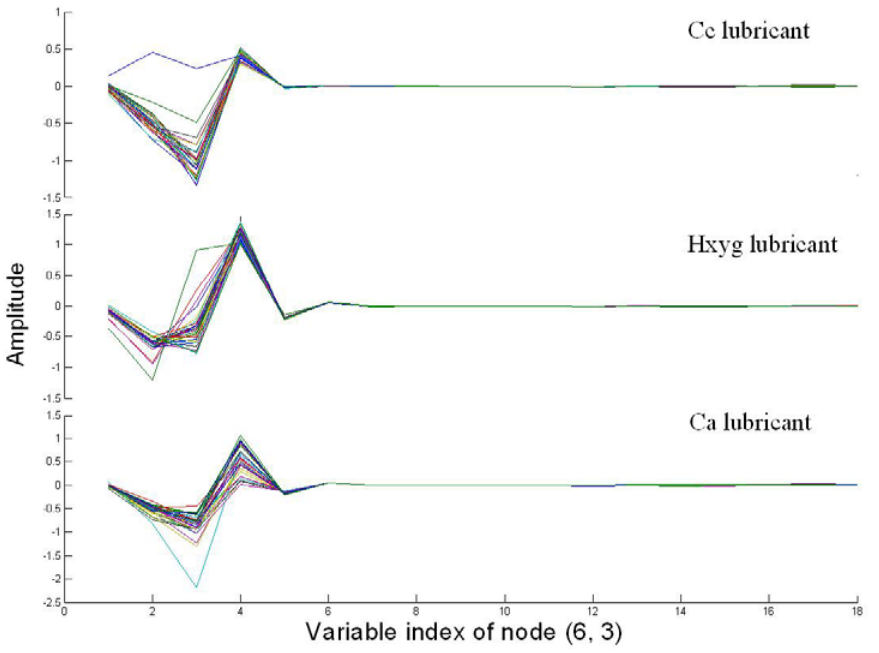
Figure 4. Characteristics of coefficients of node